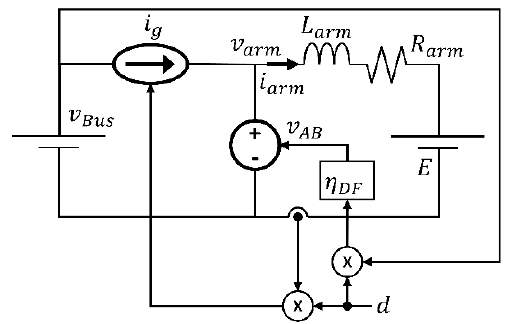
Figure 16. Averaged model of the motor drive-electric motor-vehicle system, including the inner current loop.